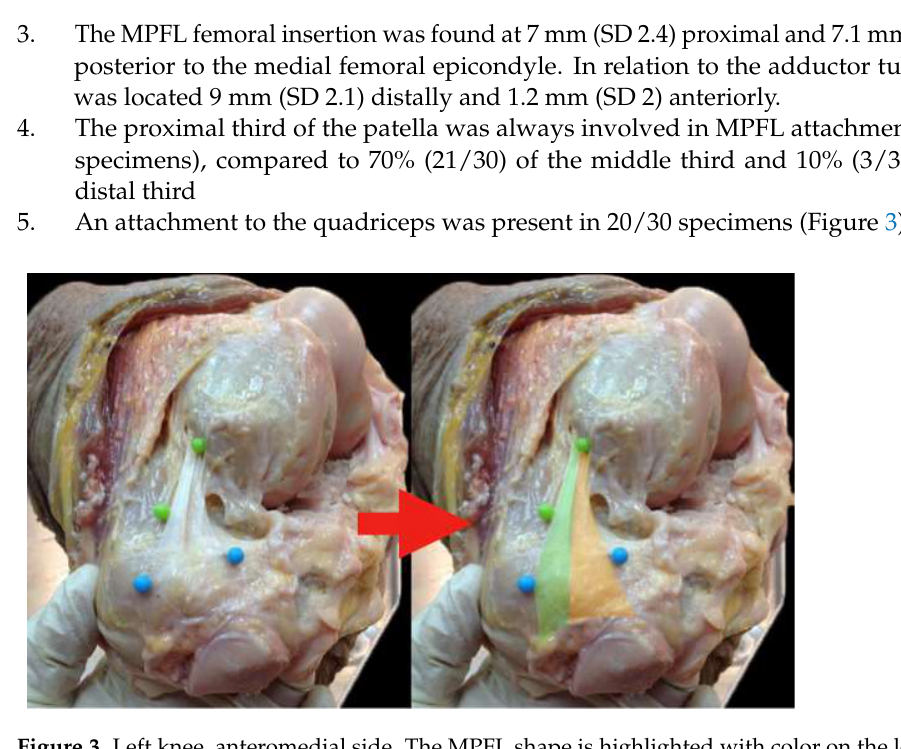
Figure 3. Left knee, anteromedial side. The MPFL shape is highlighted with color on the left part of the photo (green and orange). The green part represents the part of the MPFL that ultimately attaches at the quadriceps tendon, whereas the orange part represents that part of the MPFL inserting at the upper half of the patella.